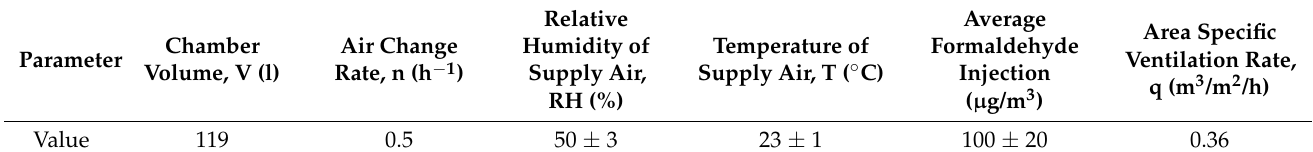
Table 3. Formaldehyde absorption test parameters.